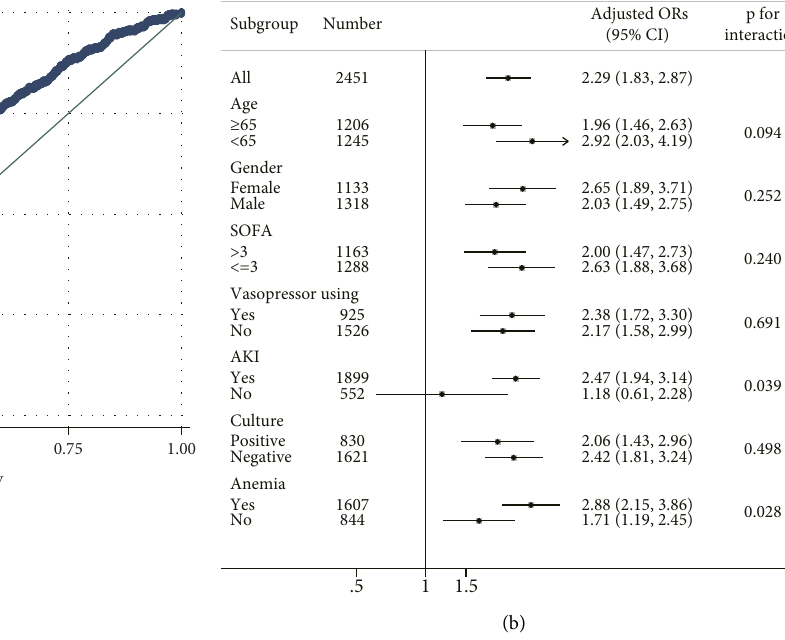
Figure 4: Receiver operating characteristic curves for serum ferritin in the entire cohort of septic patients (a). Initial serum ferritin had a moderate prediction capability with AUC � 0.651 and the optimal cut-of value � 591.5 ng/mL. Te adjusted odds ratios (ORs) of ferritin ≥ 591.5 ng/mL for in-hospital mortality in the entire cohort and diferent subgroups (b). Ferritin ≥ 591.5ng/mL was an independent risk factor of in-hospital mortality. AKI and anemia were the signifcant interactive factors. SOFA score: the sequential organ failure assessment; AKI: acute kidney